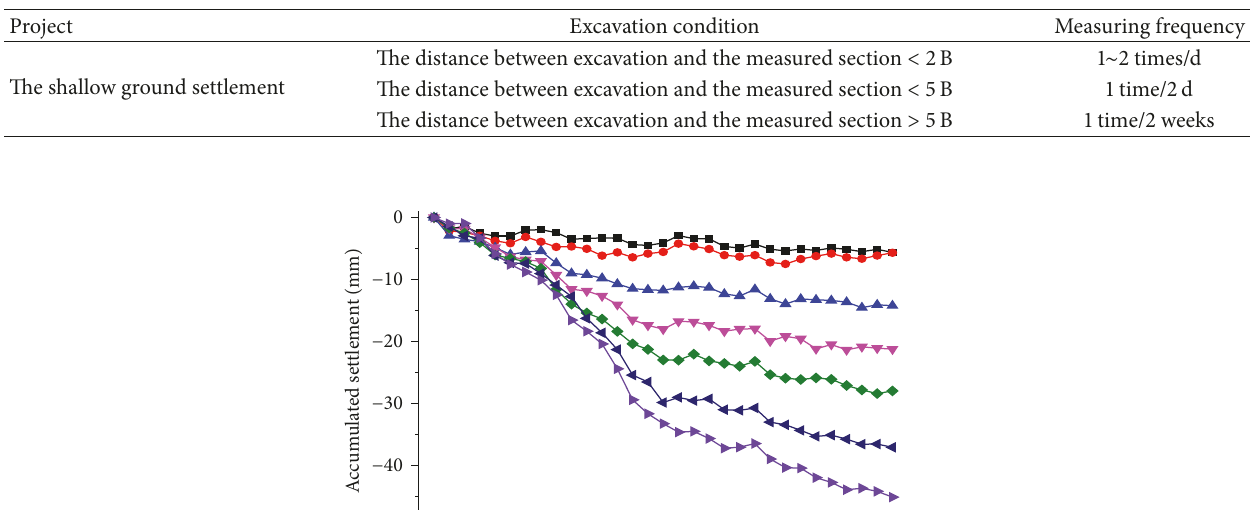
Table 3: Frequency of the shallow ground settlement measuring.